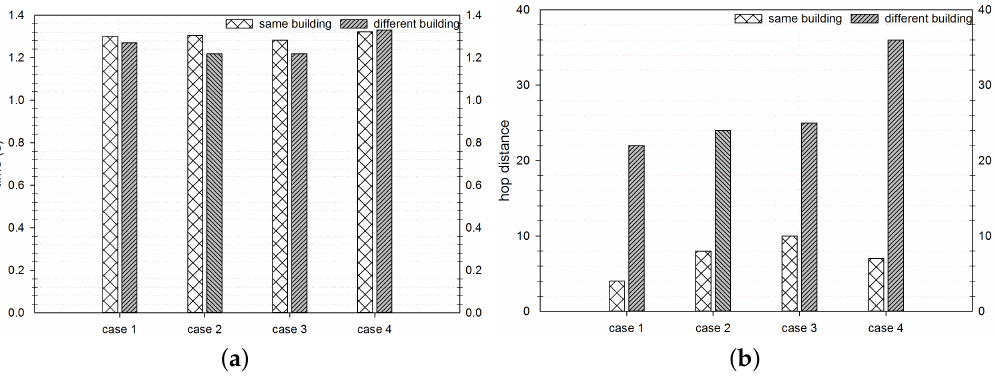
Figure 19. Performance of the path between two cells in four cases in an extreme density environment. ( a ) Response time performance; ( b ) the distance of hops in same and different